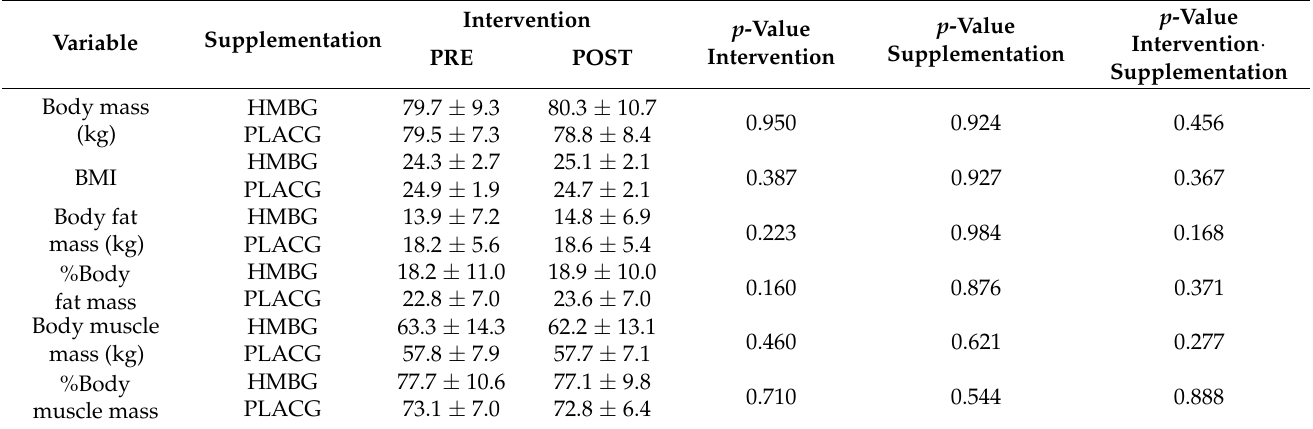
Table 1. Anthropometric variables result.